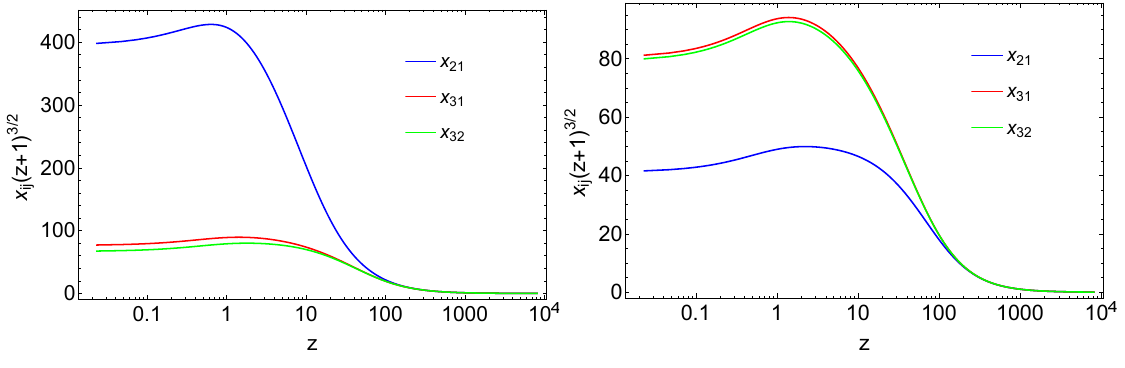
Figure 1. Evolution of the neutrino-oscillation phases ( x 21 , x 31 and x 32 ) as a function of cosmological redshift z for the three Gell-Mann blocks for normal (left) and inverted (right) hierarchy with the lightest mass state assumed to be massless, shown for neutrinos at the peak of their thermal distribution ( q = 3.15 T ν ). The mass-squared differences are inferred from the global analysis of neutrino-oscillation data